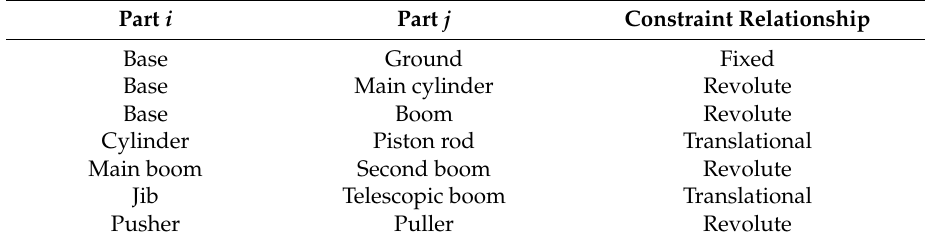
Table 1. Virtual constraints between components of the boom.